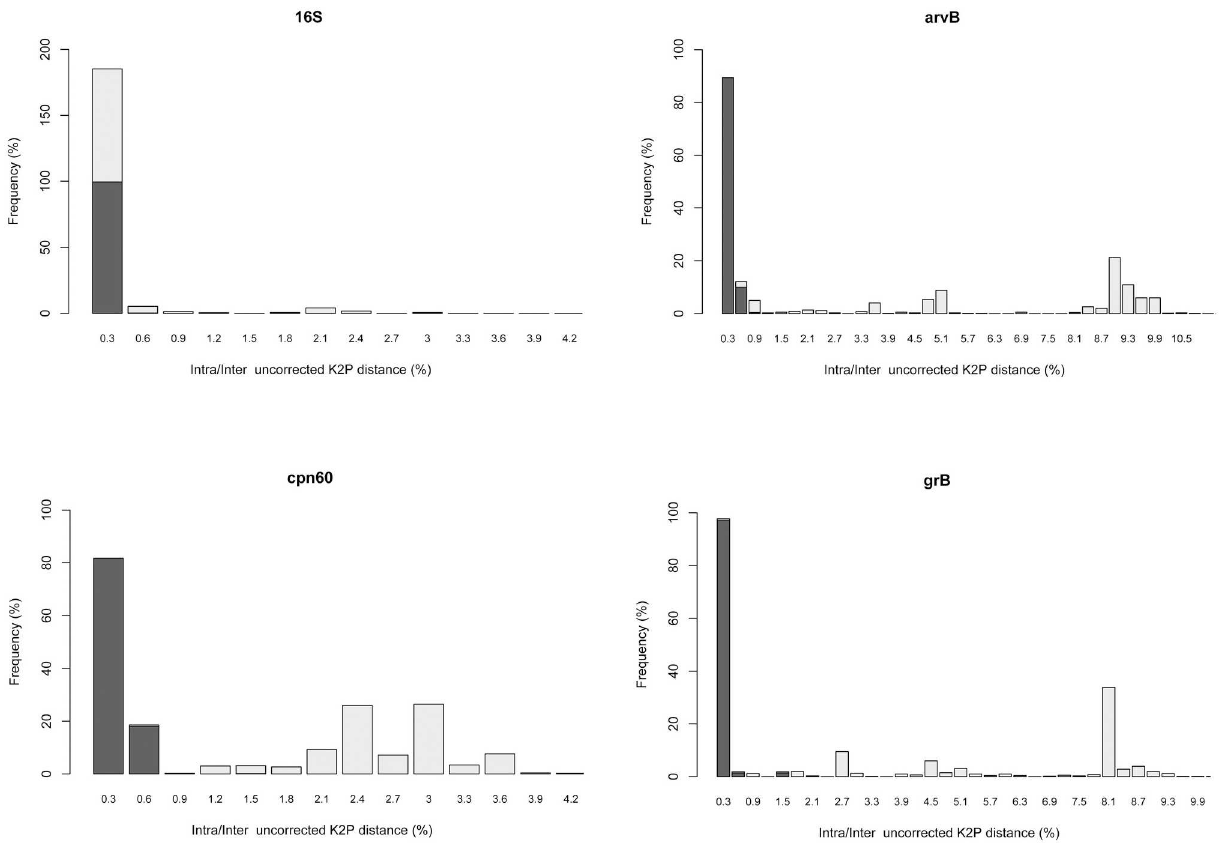
Fig 5. Histograms of the frequencies (y-axes) of pairwise intra-species/pathovar (dark gray bars) and inter-species/pathovar (light gray bars) divergences based on the uncorrected K2P distance (x-axes)for each candidate gene.